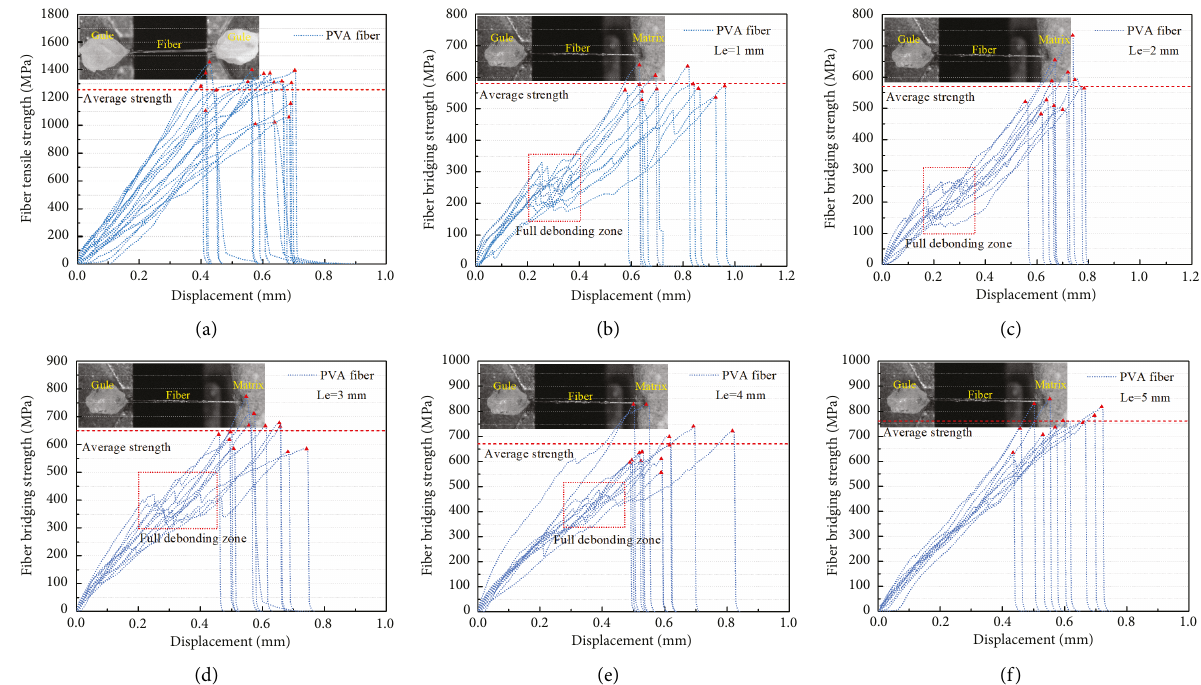
Figure 15: Single-fiber bridging strength and pullout displacement curves for different values of L pullout with L e � 1mm. (c) Single-fiber pullout with L e � 2mm. (d) Single-fiber pullout with L e � 3mm. (e) Single-fiber pullout with L e � 4mm. (f) Single-fiber pullout with L � 5mm. e